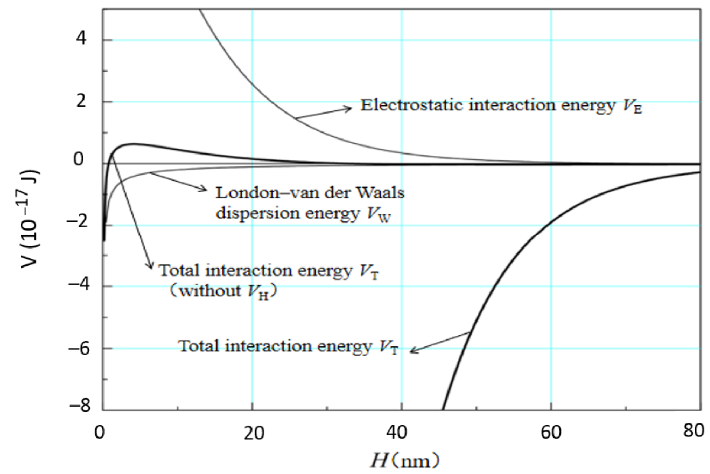
Figure 10. Interaction energy curves between ilmenite and HGB as function of interparticle interaction distance (pH: 6.0, NaOL concentration: 4.0 × 10 –4 mol·L –1 ).